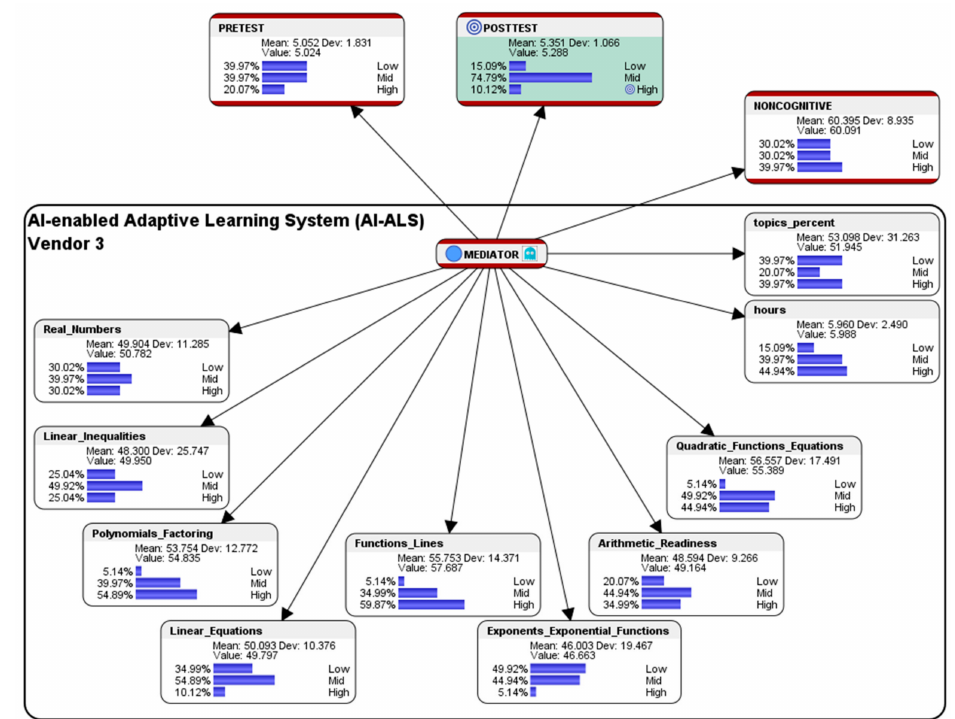
Figure 9. BN model of the students who had used the AI-ALS from Vendor 3 (N = 20 students). Visualization of the Performance of the Students Who Had Used Vendor 4 Using the file “data_ai_als_class_4.csv” via the Data Association tool in Bayesialab, the following score-clusters machine-learned by Bayesialab were observed from the dataset depicting the performances of the 20 students who had used the AI-ALS from Vendor 4, (see Figure 10):